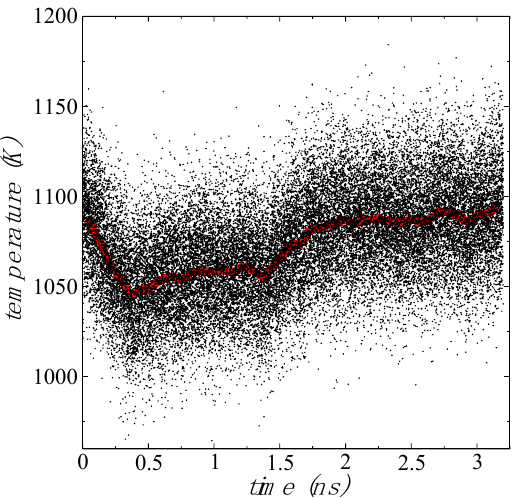
Figure 4. Temperature of 1L Mo 243 S 486 flake as a function of the simulation time, under vacuum and NVE conditions starting from an equilibrated configuration at 1100 K (NVT). Points represent time averages for every 100 configurations. Red line represents the average value for every 1000 configurations.